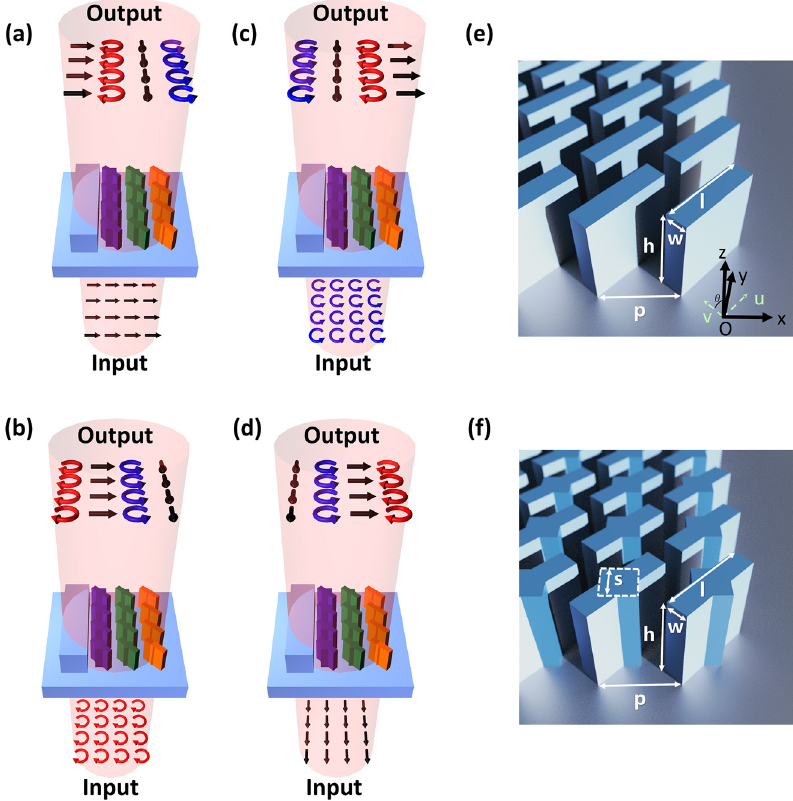
Figure 1: Schematic illustrations of CN – based